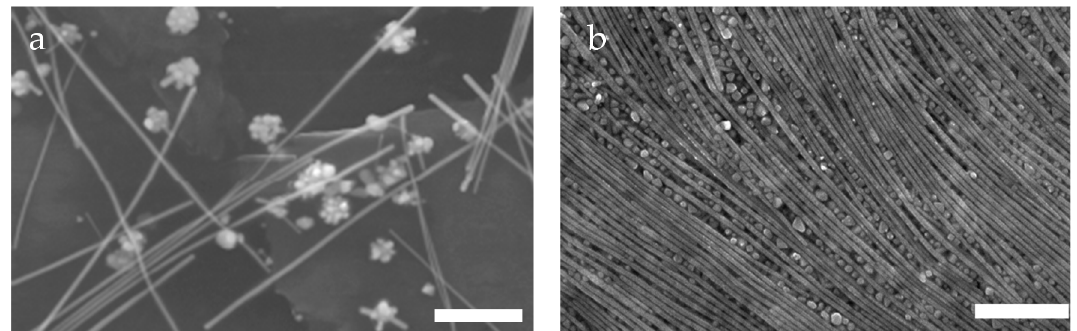
Figure 12. Scanning electron micrographs of silver nanomaterials produced by the microwave assisted polyol method ( a ) nanowires and spherical nanoparticle aggregates, ( b ) after shear the demixed nematic forms more aligned wires on a surface of packed nanoparticles. Scale bars are 1 μ m. Adapted with permission from Murali, S.; Xu, T.; Marshall, B.D.; Kayatin, M.J.; Pizarro, K.;